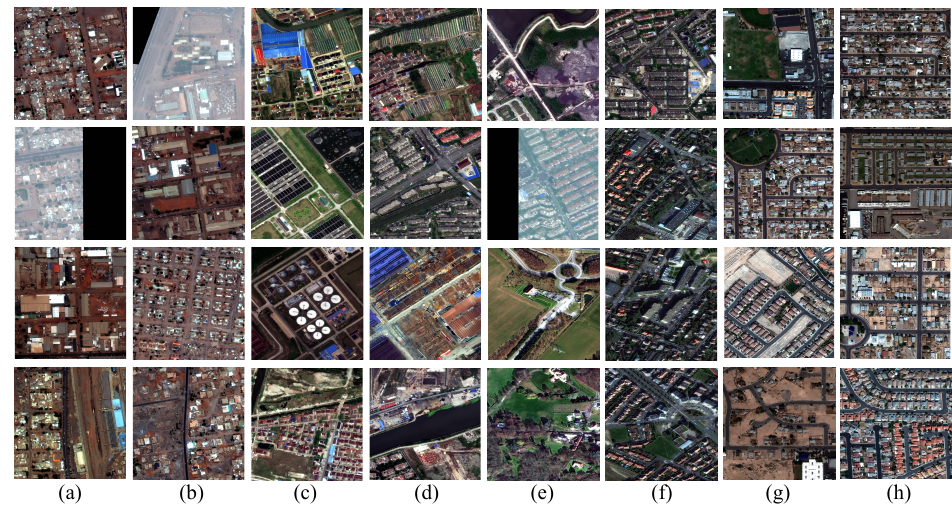
Figure 9. Overview of the SpaceNet dataset area from ( a , b ) Khartoum; ( c , d ) Shanghai; ( e , f ) Paris; ( g , h ) Vegas.